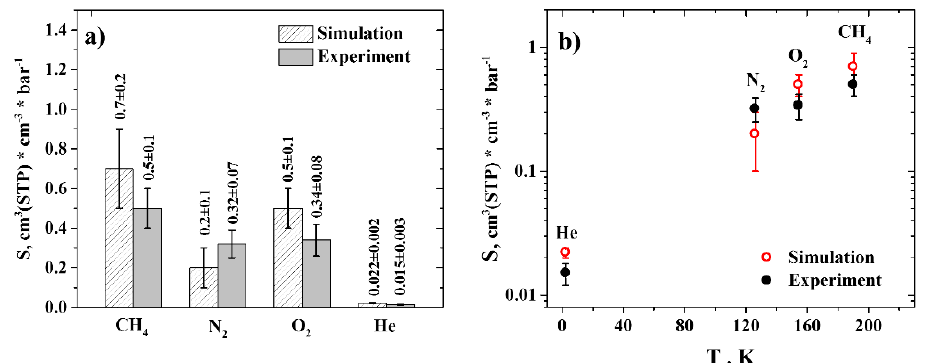
Figure 4. ( a ) Solubilities of gases in R-BAPB under STP conditions obtained in molecular dynamics simulations (shaded columns) and in experiment (solid columns). ( b ) Solubilities of gases in R-BAPB versus their critical temperatures obtained in molecular dynamics simulations (blank red circles) and in experiment (solid black circles). Semi-logarithmic axes. The error bars denote standard deviation.